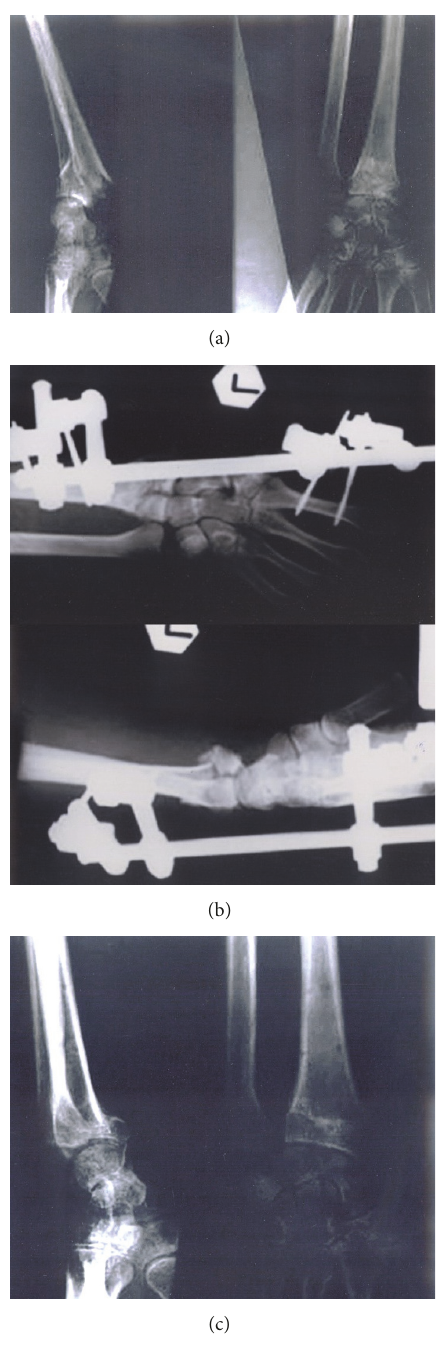
Figure 1: Preoperative (a), postoperative (b), and final follow-up radiographs of EF group